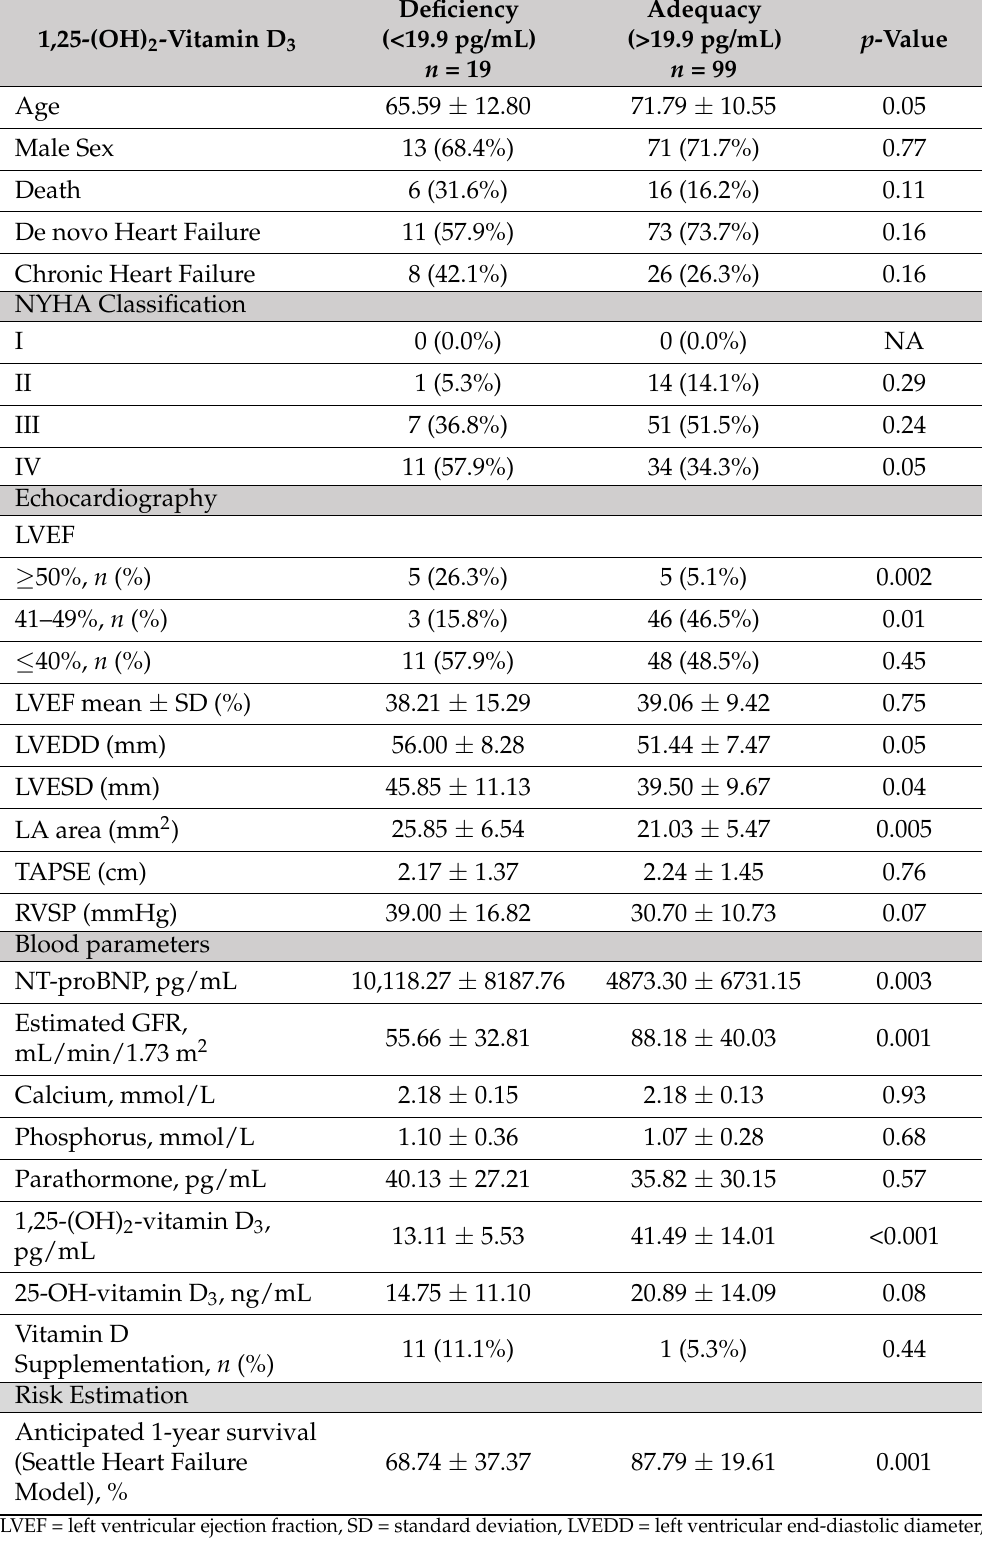
Table 3. 1,25-OH-vitamin D 3 levels in HF patients ( n =